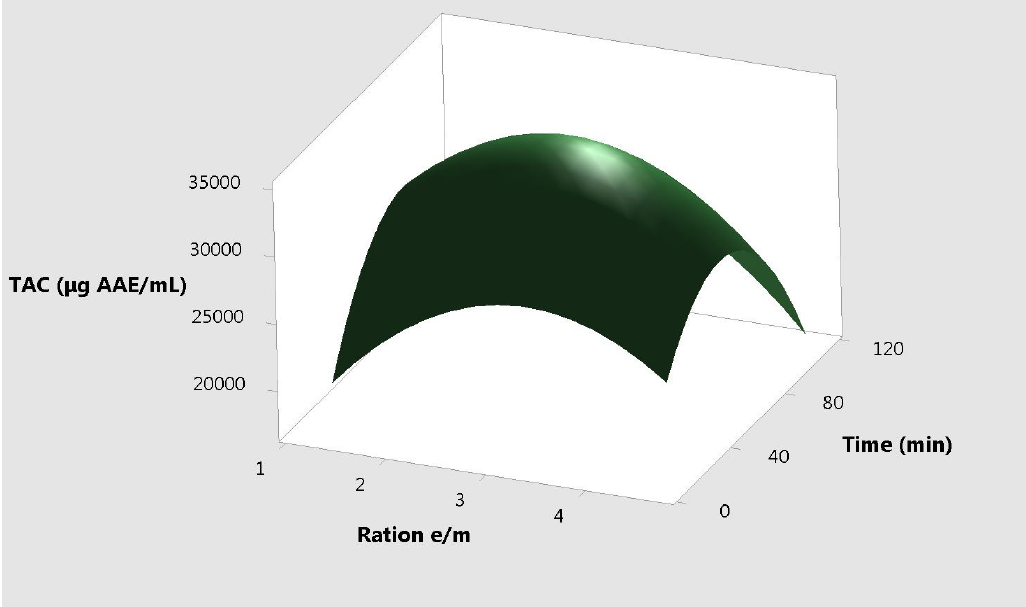
Figure 5. Surface plot of the total antioxidant capacity vs. time and ratio e/m.